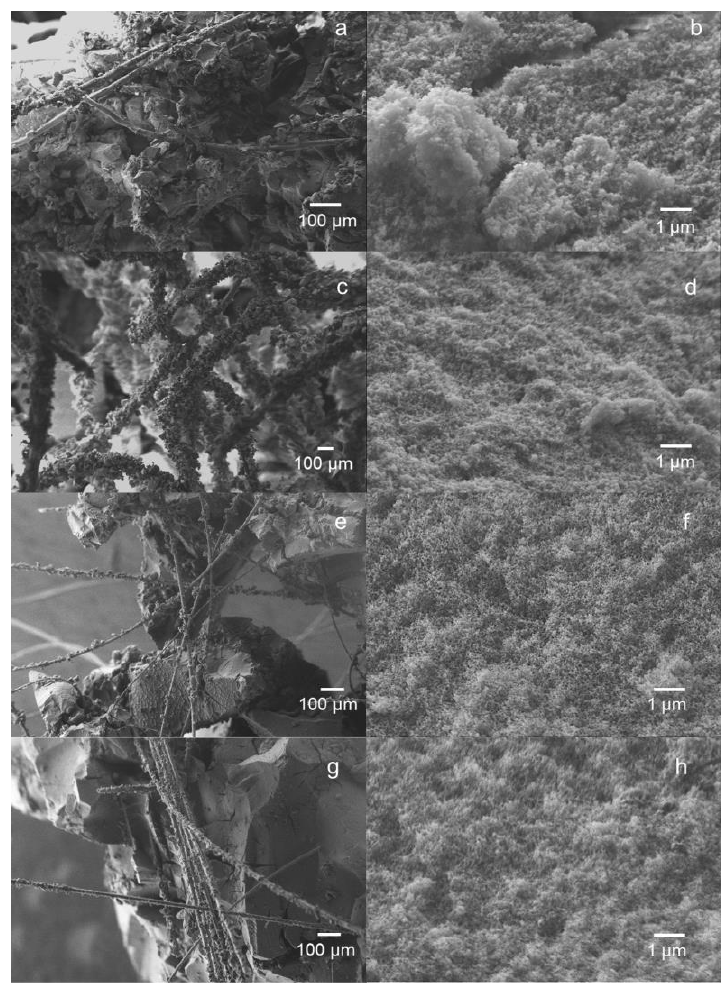
Figure 6. SEM images of rubber-silica composites reinforced with ( a , b ) recycled tire textile fiber, ( c , d ) polyester fiber blanket, ( e , f ) silica fiber felt, and ( g , h ) glass wool. ( a , c , e , g ) Interaction of the silica phase with the fibers; ( b , d , f , h ) rubber and silica matrix.